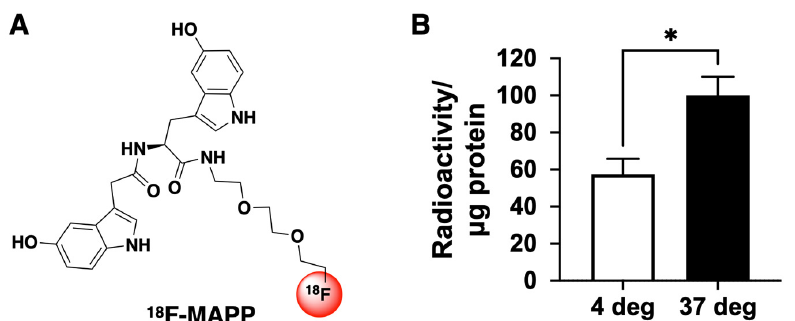
Figure 1. ( A ) Structure of 18 F-MAPP. ( B ) 18 F-MAPP can cross the cell membrane. After neutrophils were incubated with 18 F-MAPP for 1 h and then washed to remove 18 F-MAPP in the medium, radi- oactivity was still found in the neutrophils. Interestingly, the uptake was signi fi cantly higher at 37 °C than that at 4 °C, suggesting intracellular uptake may have both passive di ff usion and energy- dependent components (* p < 0.05, n = 4, two-tailed t -test. Radioactivity was normalized to protein amounts obtained from BCA protein assay after gamma